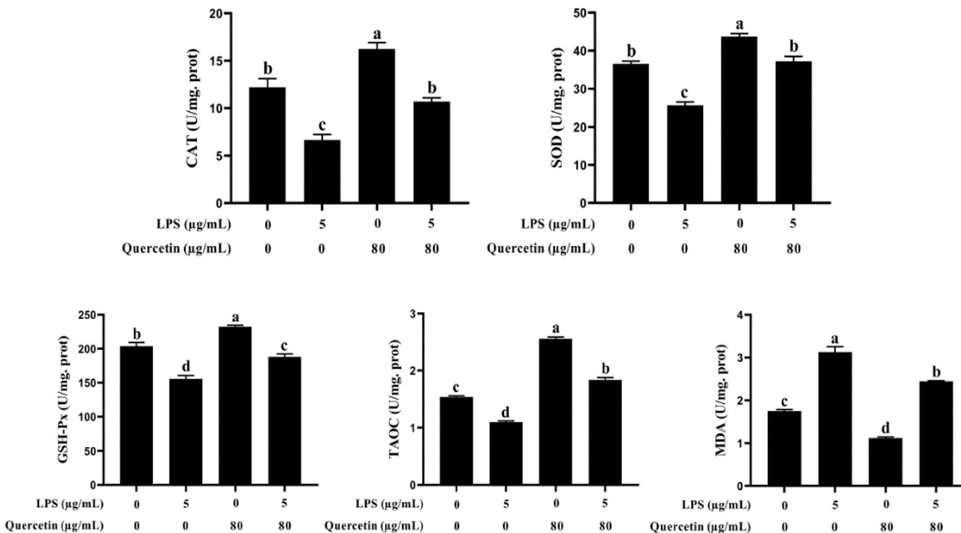
Figure 2. Impacts of quercetin on oxidative features in LPS-induced BIECs. BIECs were given 5 μ g/mL LPS and 80 μ g/mL quercetin. After 6 h of culture, the cells were gathered. The results are mean ± SEM (n = 6). Various lowercase letters in the line graph show significant changes ( p < 0.05).